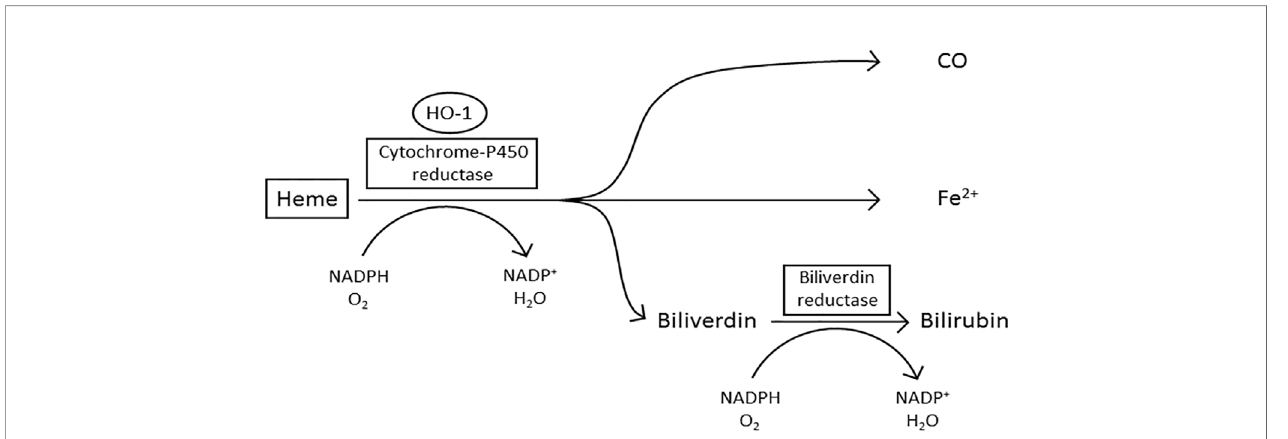
FIGURE 1 | The oxidative degradation of heme by HO-1. In the fi rst step of heme degradation, the ER membrane bound HO-1 interacts with the electron donor NADPH-cytochrome P450 reductase, and an oxygen molecule. The complex degrades heme to biliverdin, carbon monoxide (CO), and a ferrous iron (Fe 2+ ). NADPH- biliverdin reductase competitively binds to HO-1 to reduce biliverdin to bilirubin, by using NADPH as an electron donor (1,